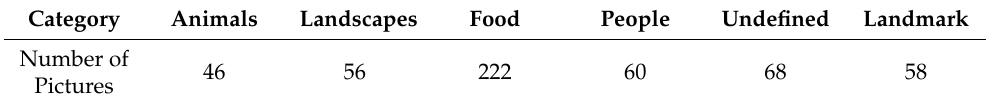
Table 5. Classifying pictures by